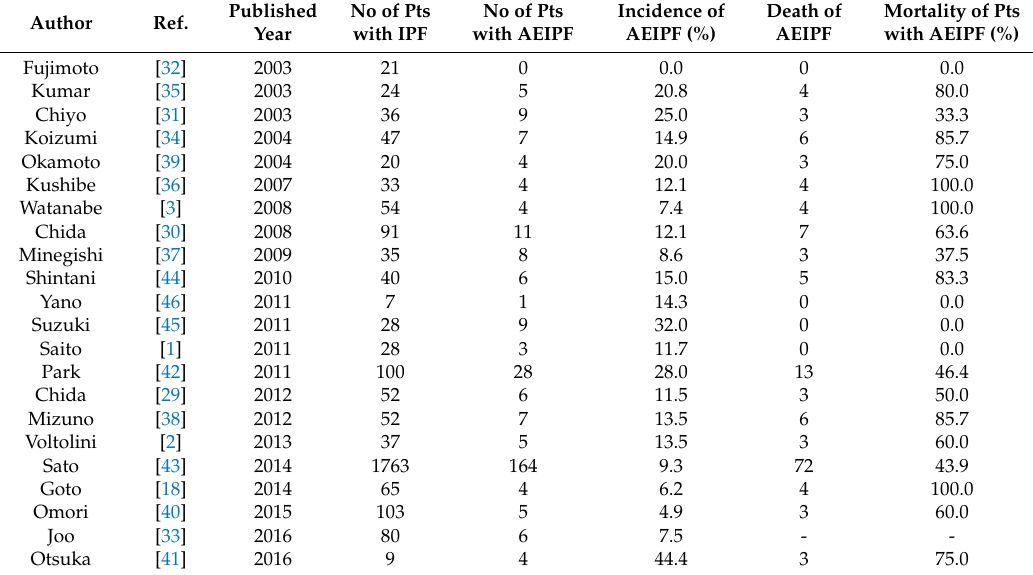
Table 1. Reports on postoperative acute exacerbation of idiopathic pulmonary fibrosis in non-small cell lung cancer patients with idiopathic pulmonary